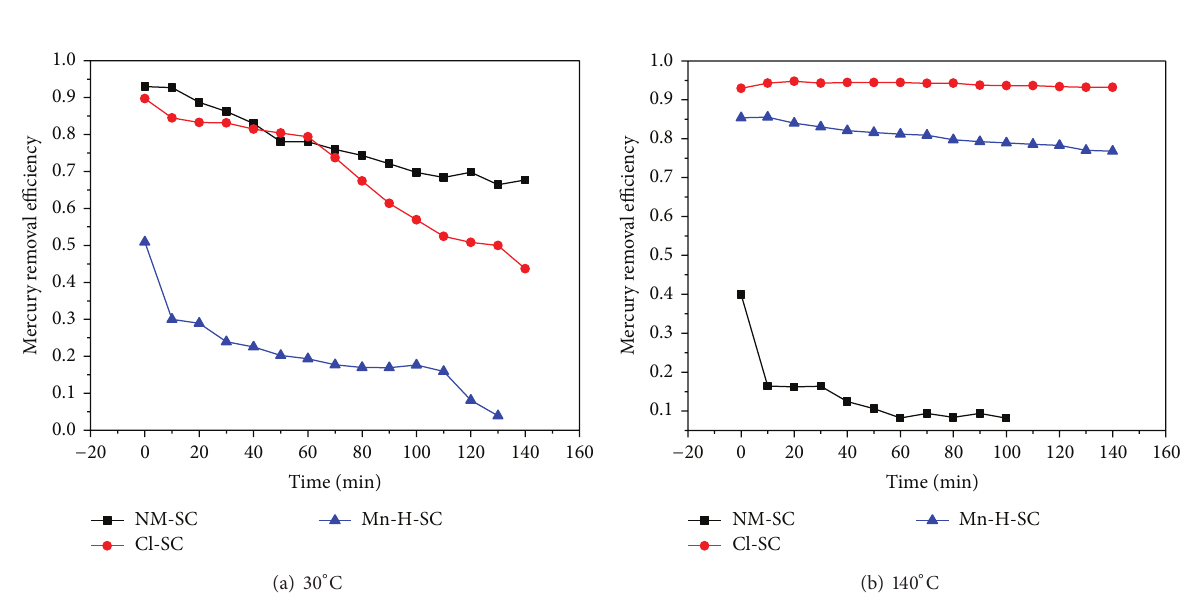
Figure 2: Mercury removal efficiency of NM-SC, Cl-SC, and Mn-H-SC at 30 ∘ C and 140 ∘